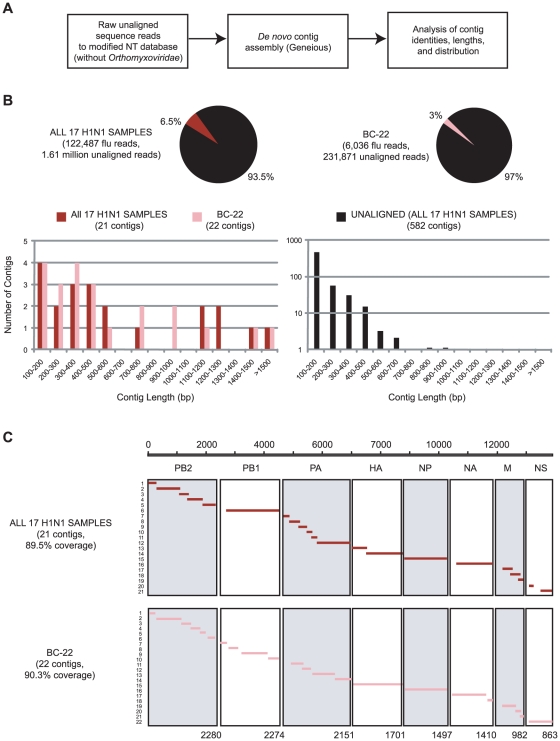

De novo assembly of the 2009 H1N1 genome.(A) Algorithm for de novo assembly of the 2009 H1N1 genome assuming no a priori knowledge of the Orthomyxoviridae family and thus, no available reference genome. (B) Plot of number of contigs vs. contig length for de novo assembled contigs mapping to 2009 H1N1 influenza derived from all 17 pooled samples (dark red) or sample BC-1422 alone (pink), as well as for unaligned contigs (black). Note that the longest contigs all map to 2009 H1N1, even though influenza reads in all 17 pooled samples or BC-1422 comprise only 7.6% or 2.6% of the total reads, respectively. (C) Coverage of the 2009 H1N1 genome by de novo contig assembly from reads corresponding to all 17 pooled samples (top, dark red lines) or BC-1422 alone (bottom, pink lines).